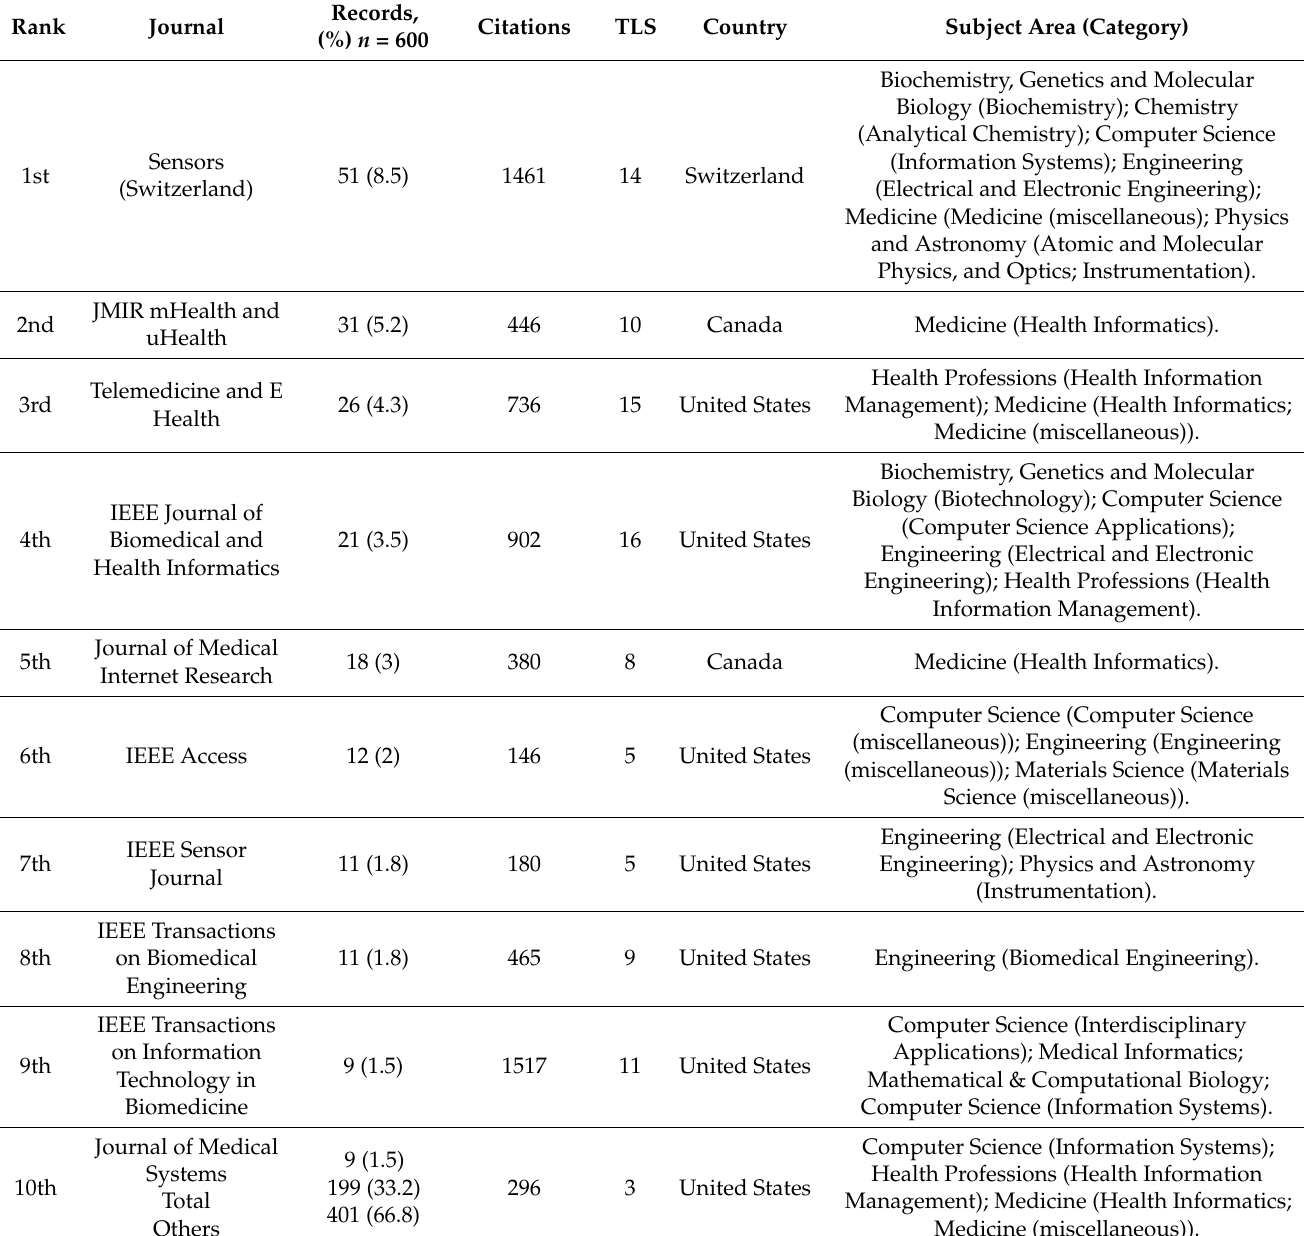
Table 4. The 10 most active journals in the field of